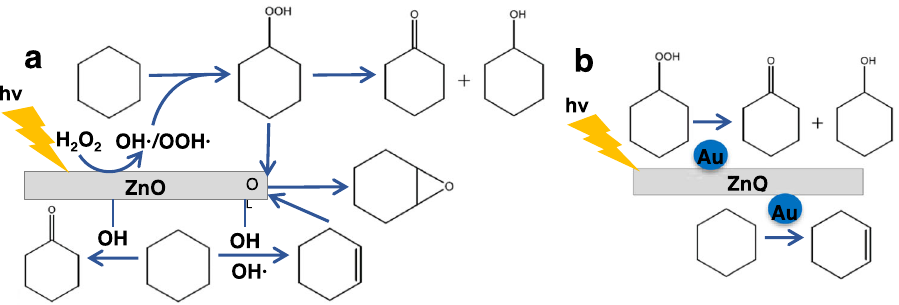
Fig. 6 | Cyclohexane oxidation, dehydrogenation, and epoxidation pathways. a PhotocatalyticoxidationofcyclohexanewithZnOnanorodpresentinHPcatalyst. ·OH/·OOH radicals are produced from excitation of H 2 O 2 and ZnO which form cyclohexyl hydroperoxide. ZnO OH sites result in dehydration to cyclohexene which isthencombined with cyclohexyl hydroxideat a latticeOH site (O L ) to form